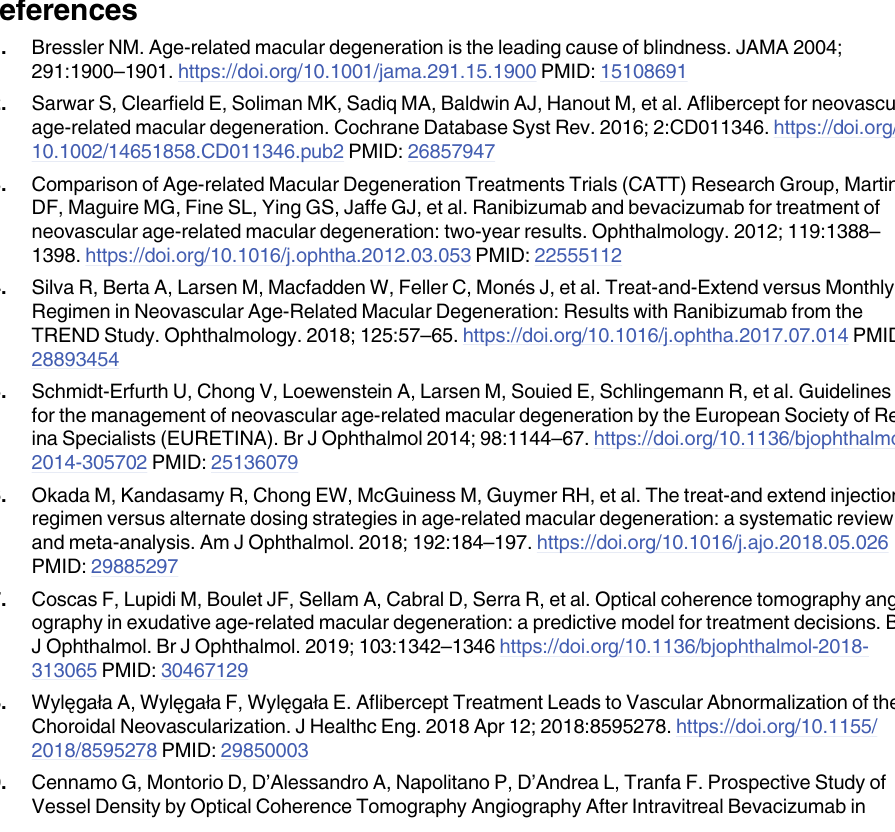
S1 Table. The original dataset used for